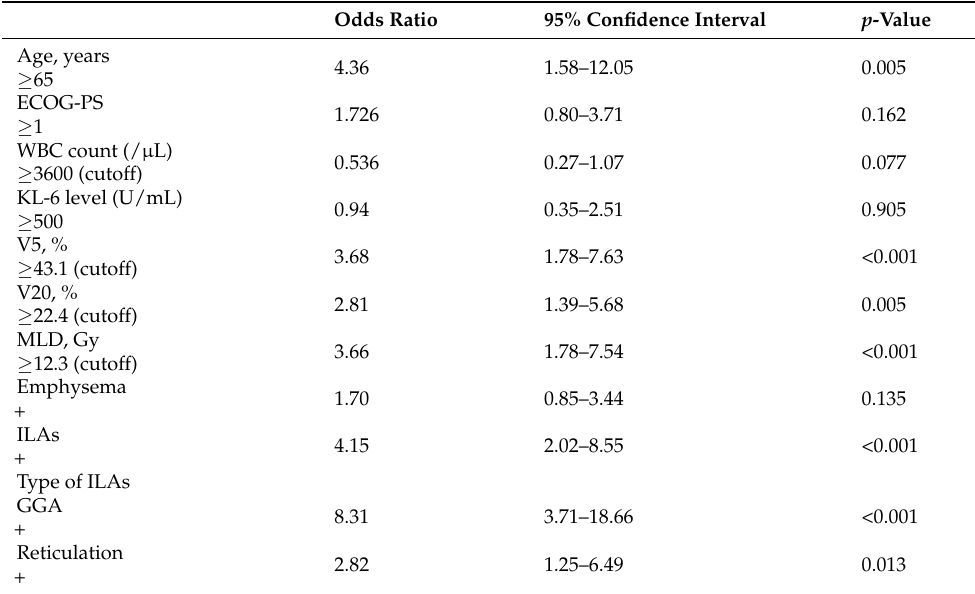
Table 4. Univariate logistic regression analysis of risk factors for grade ≥ 2 ILD.